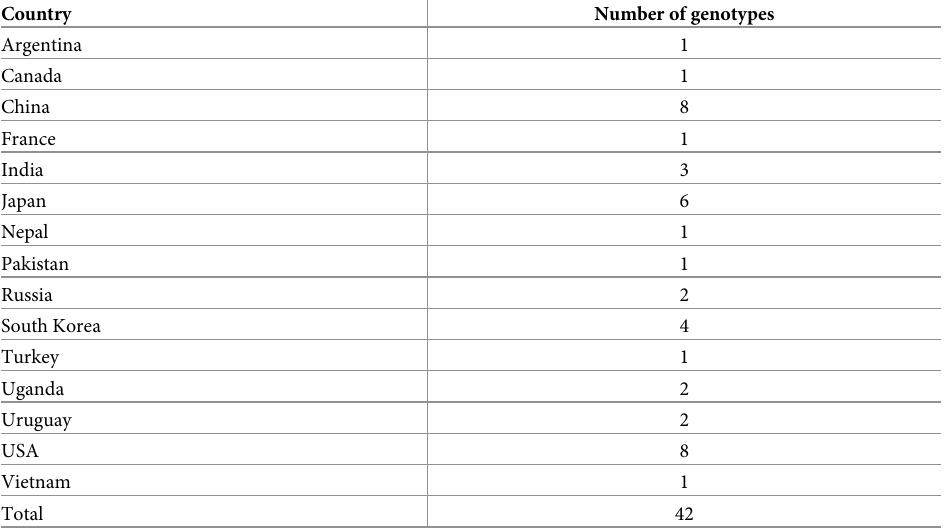
Table 1. Country of origin for soybean entries evaluated for reaction to natural field infection by Cercospora spe- cies in Stoneville, Mississippi, during 2010–2012.